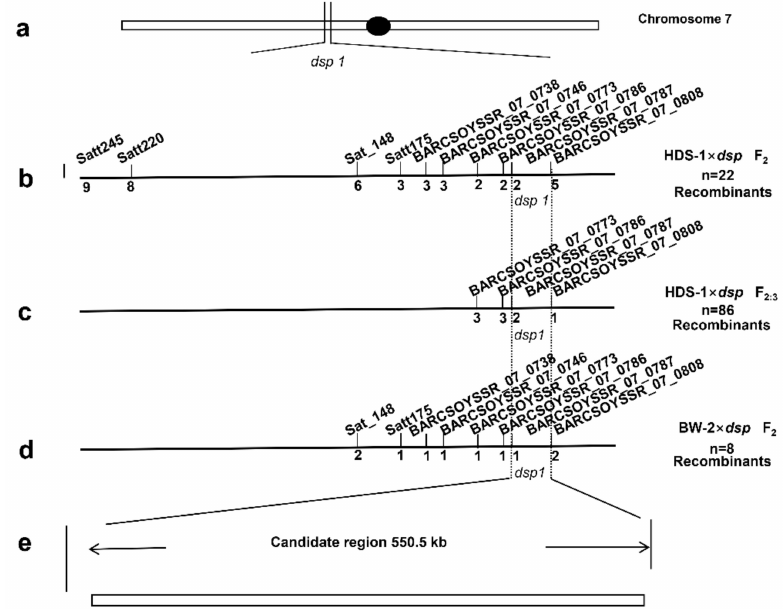
Figure 2. Mapping of the dsp1 locus. ( a – d ) Two F 2 populations of HDS-1 × dsp ( b ) and BW-2 × dsp ( d ) were used here. One F 2:3 population derived from Dsp1dsp1dsp2dsp2 F 2 plants of HDS-1 × dsp cross was used to verify the mapping result of dsp1 ( c ). The dsp1 locus was mapped to a 550.5-kb region nearby centromere on chromosome 07 with BARCSOYSSR_07_0787 and BARCSOYSSR_07_0808 as flanking markers ( e ). Black spot represents centromere. Number below every SSR marker means recombinant individual